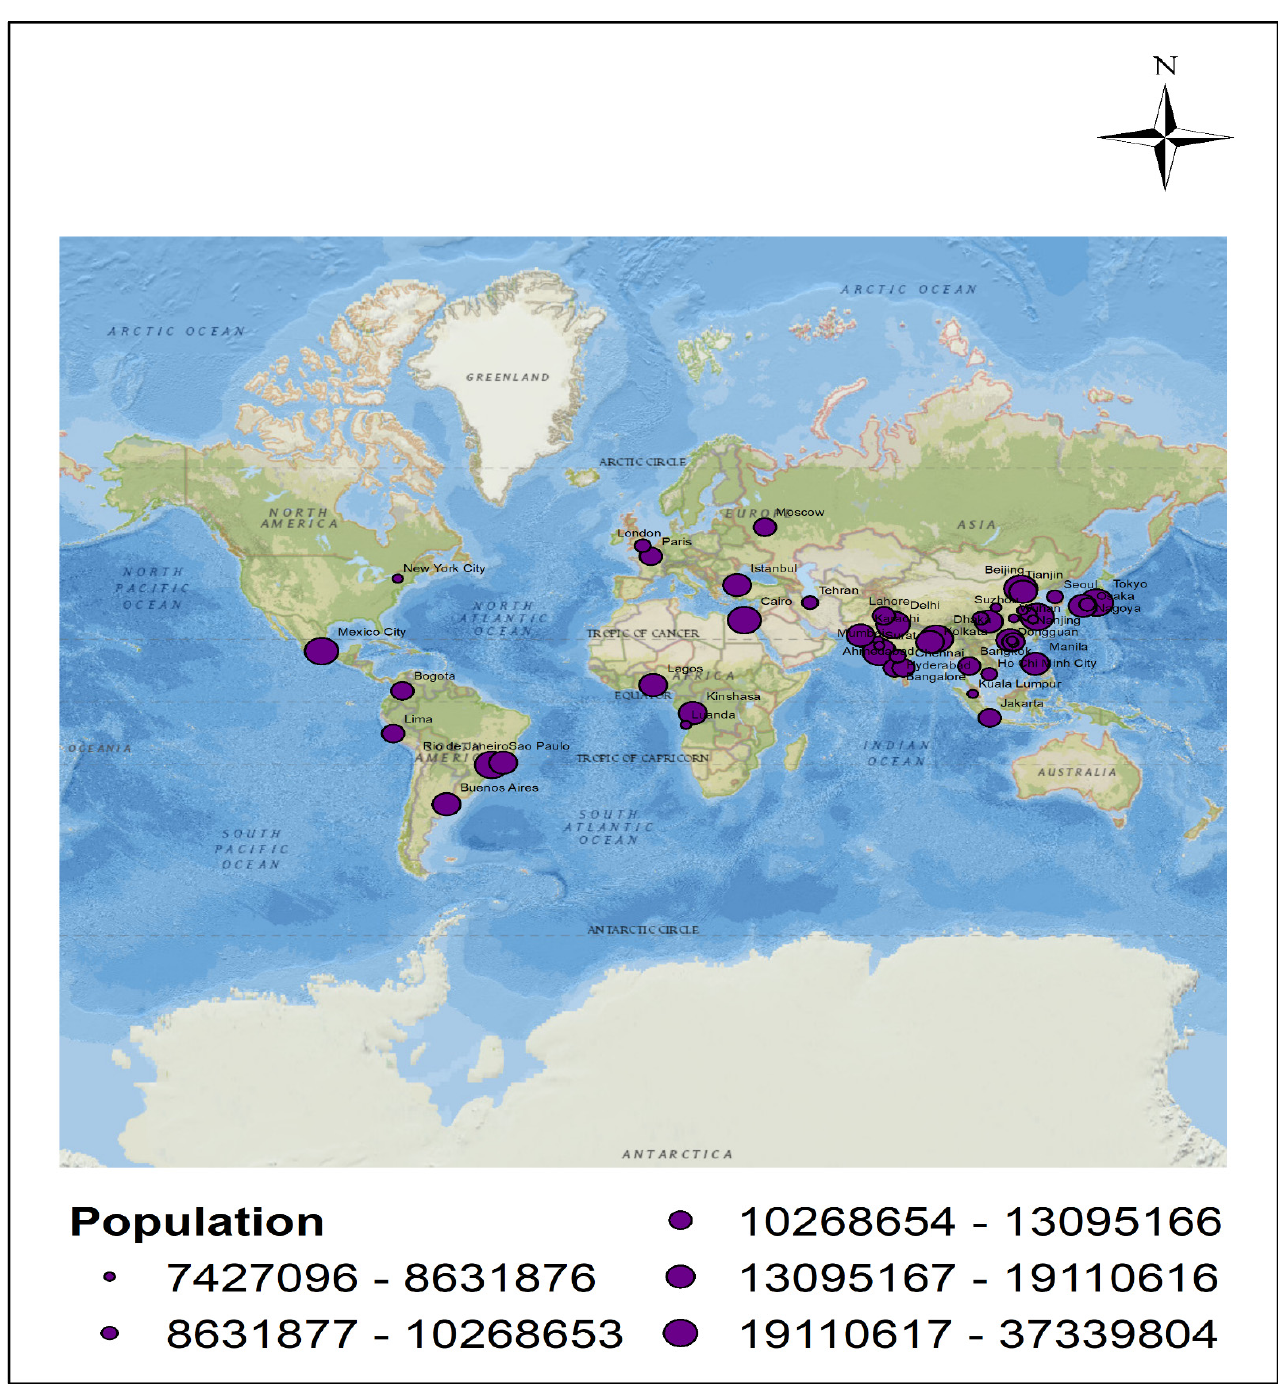
Figure 1. Geo-visualization of the most relevant metropolitan city of the world analyzed in the present study.